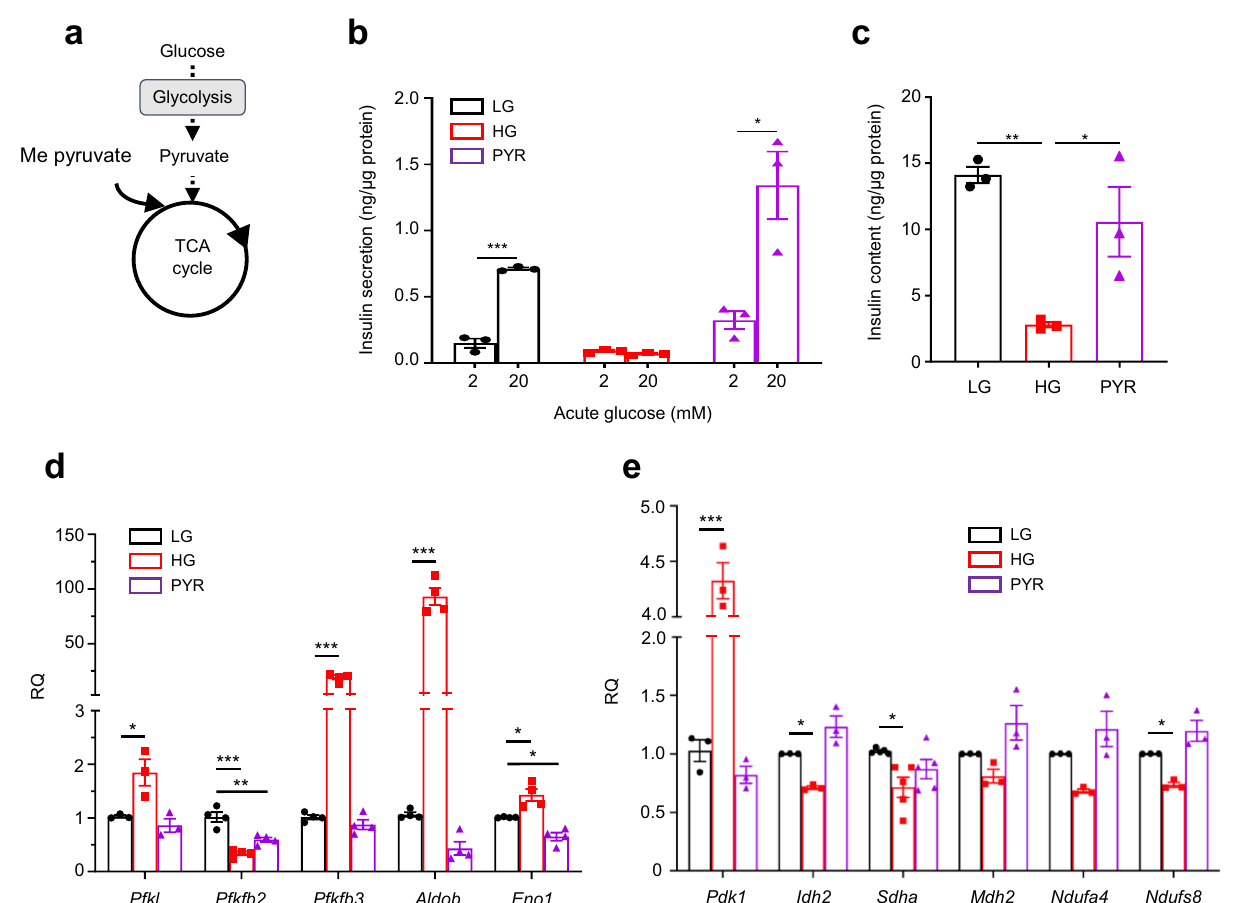
Fig. 2 | Chronic effects of the mitochondrial substrate pyruvate on insulin secretion. a Schematic showing where methyl pyruvate (Me-pyruvate) enters metabolism. b , c Insulinsecretion( b )andinsulincontent( c )inLG-andHG-cells,or cells cultured with 20mM methyl pyruvate for 48h (PYR) ( n =3 biologically independent experiments). d , e mRNA levels for the indicated genes involved in glycolytic ( d ) and mitochondrial ( e ) metabolism assessed by qPCR in LG- and HG- cells,orcellsculturedwith20mMmethylpyruvatefor48h( Pfkl,Pdk1,Idh2,Mdh2,